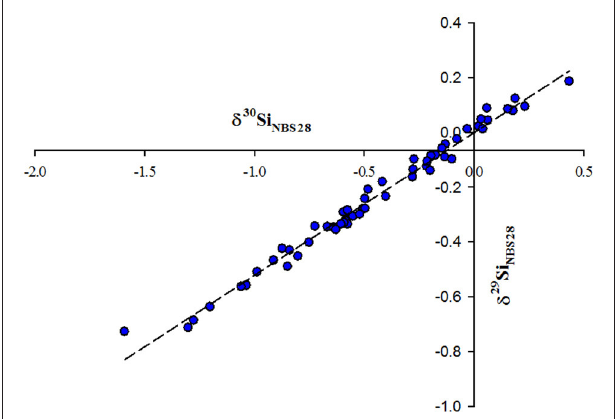
FIGURE 1 | Mass dependent fractionation of δ 29 Si vs. δ 30 Si for all diatom samples relative to NBS-28. Regression line represents δ 29 Si = [0.520 ± 0.009]. δ 30 Si − 0.002 ± 0.006, ( r 2 = 0.99, n = 55